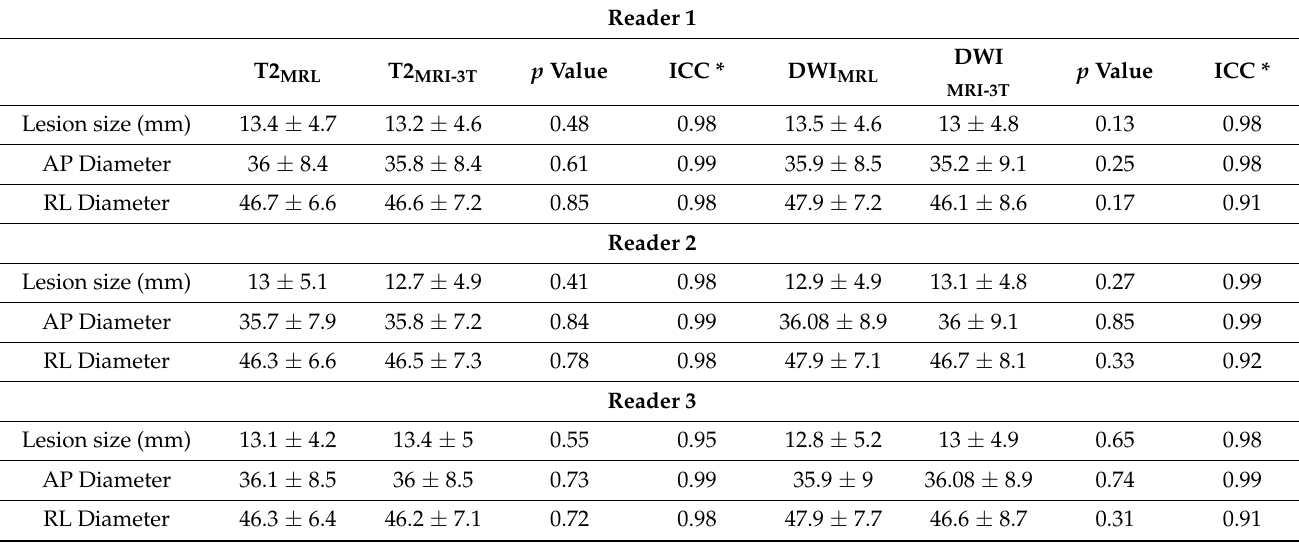
Table 6. Comparison of lesion size measurement as well as prostate diameter measurements on T2w- and DWI between MRL and as well intersequence agreement between MRL and MRl 3T for each